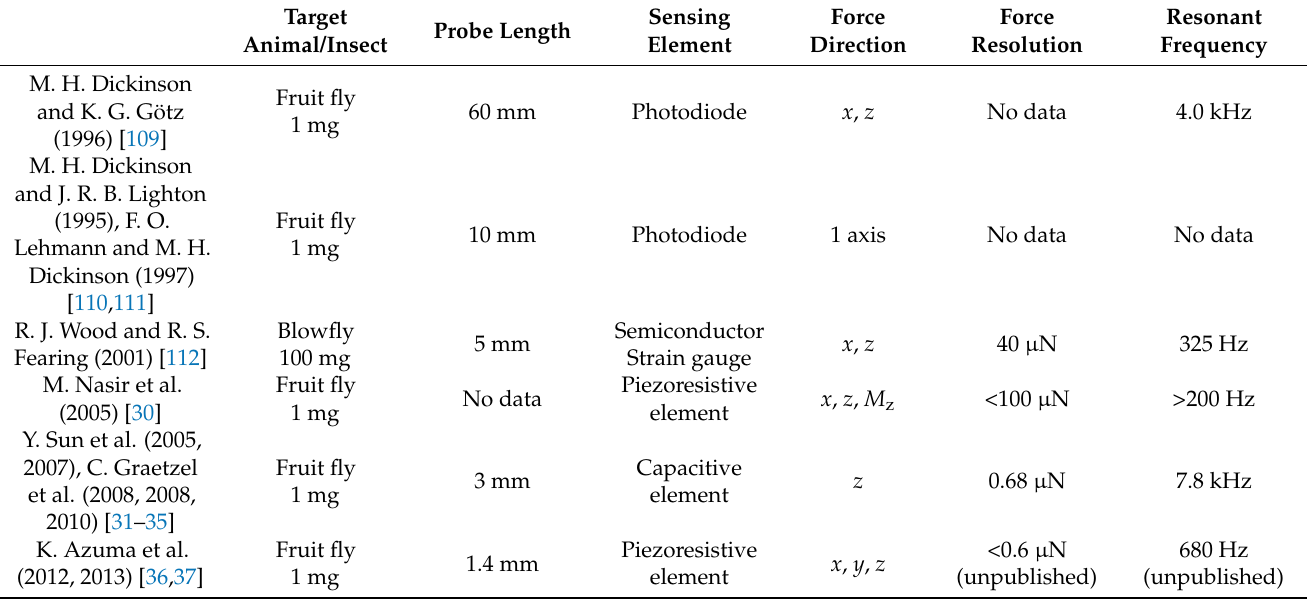
Table 2. Specifications of the developed force probes. The force probes were designed according to the size and motion of the measurement